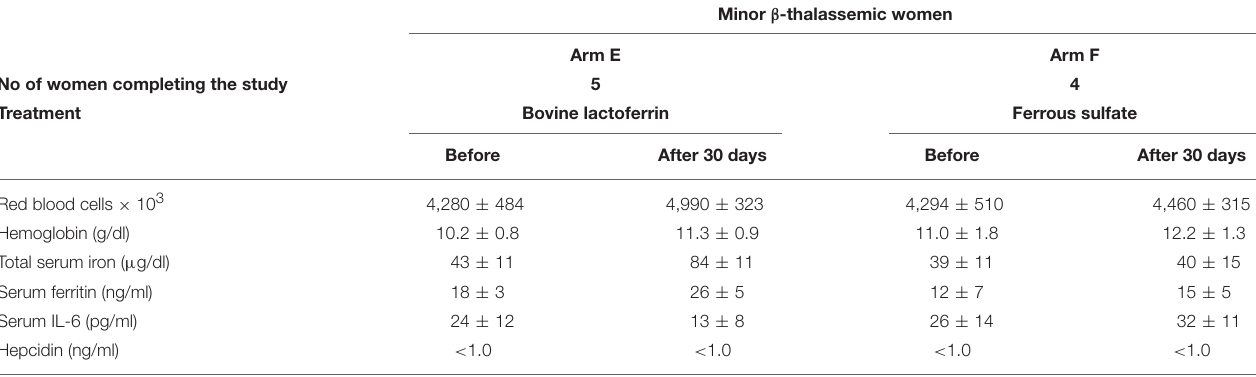
TABLE 9 | Hematological parameters, serum IL-6 and hepcidin mean values ± SD of anemic minor β -thalassemic women of child-bearing age treated with bovine lactoferrin (Arm E) or with ferrous sulfate (Arm F), before and after 30 days of treatment.